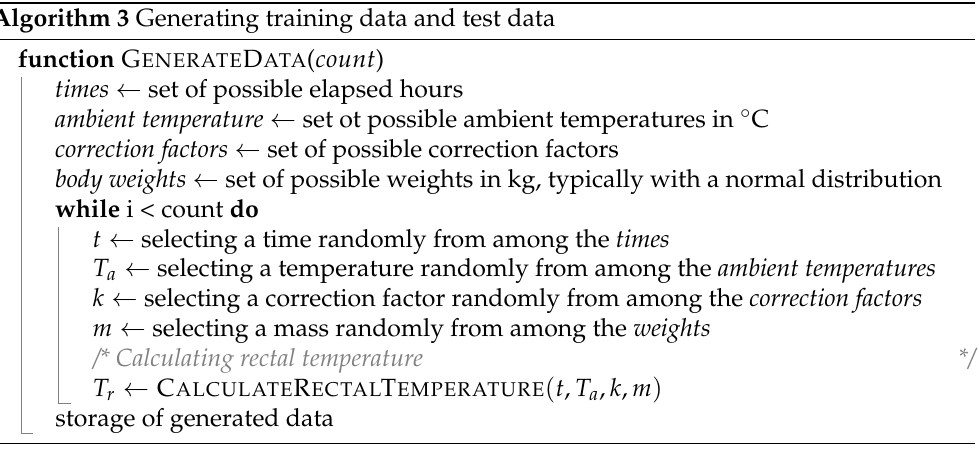
Algorithm 3 Generating training data and test